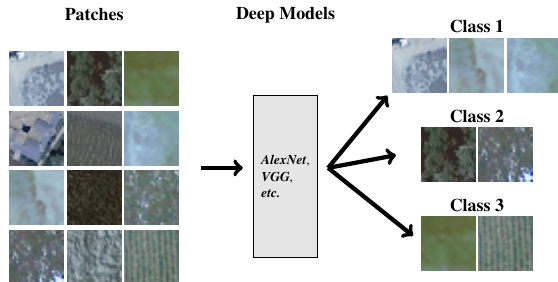
Figure 1: Certain state-of-the-art models have been tested on the publicly available SAT-4 and SAT-6 high resolution satellite mul- tispectral datasets. All the models have been designed and trained based on the DeepSat